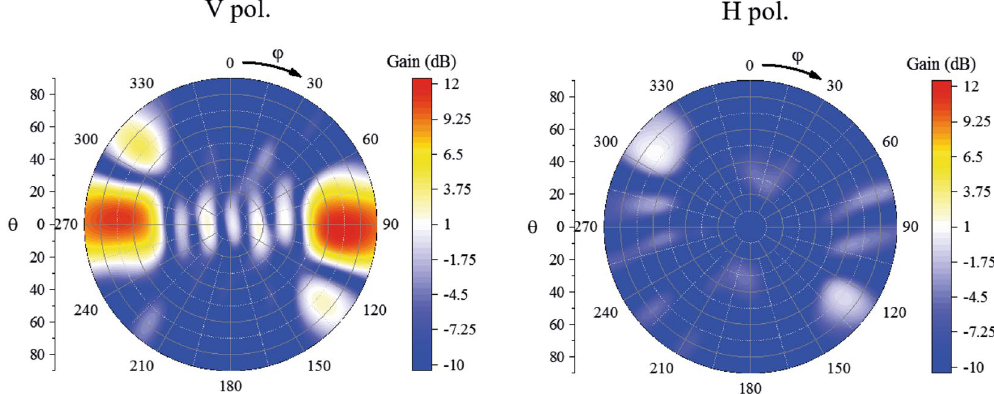
Figure 16. Bidirectional radiation patterns of the array. The H pol. and V pol. represent the horizontally polarized component and vertically polarized component, respectively. The 3-dB beamwidth of the vertically polarized component can cover bidirectional near-end-fire directions, including θ